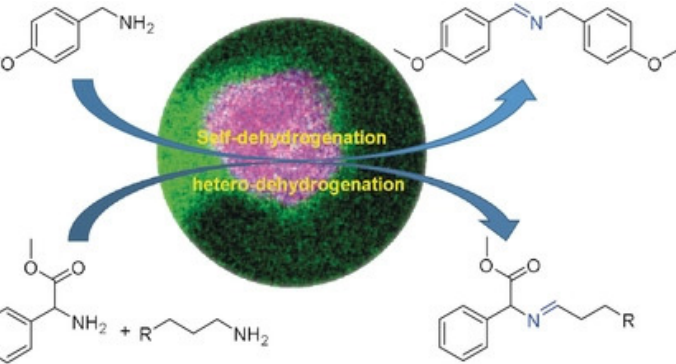
Figure 8. Selective acceptorless dehydrogenation of primary amines to imines.by Co-N/C-800 catalyst. Reprinted with permission from Ref. [33]. Copyright © John Wiley & Sons 2020.